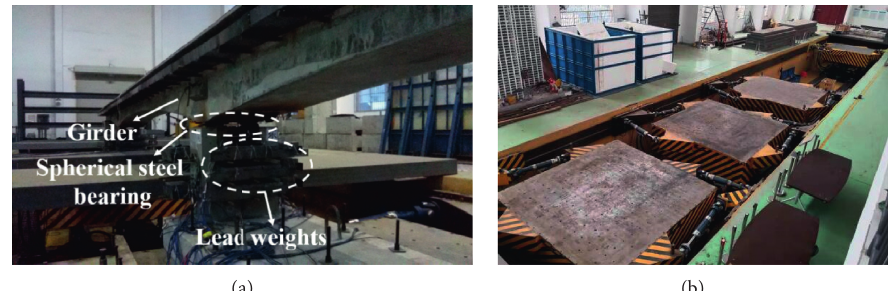
Figure 5: (a) Assembled HSRB experimental model. (b) Shaking table system.